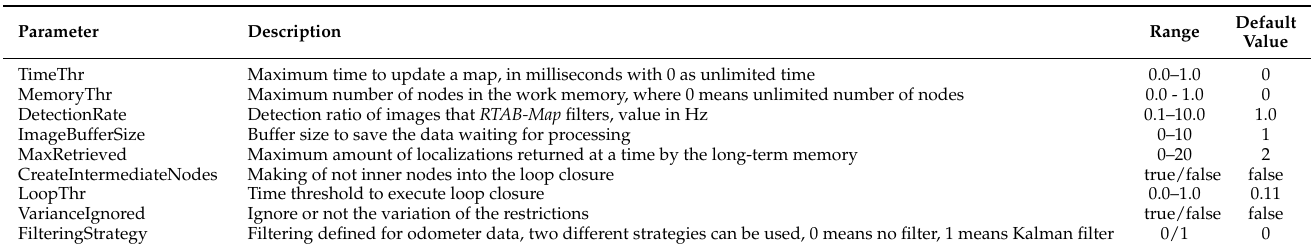
Table 5. List of RTAB-Map parameters.